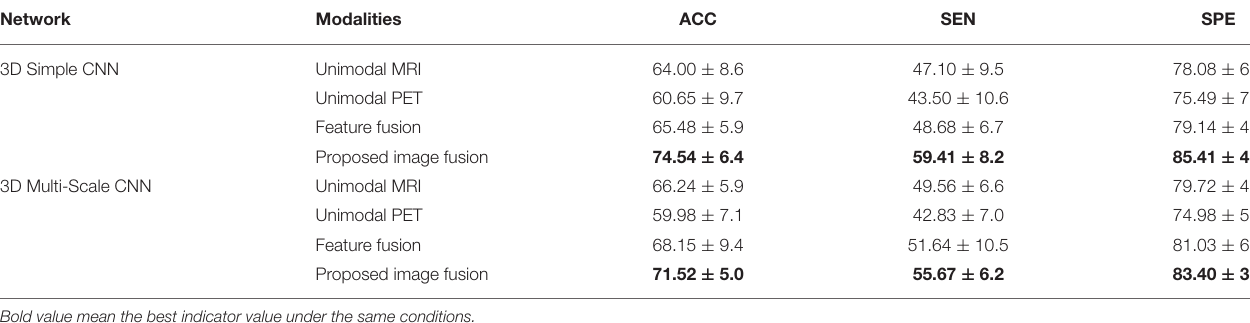
TABLE 5 | Results of different modalities with different networks for AD vs. MCI vs. NC (UNIT:%).